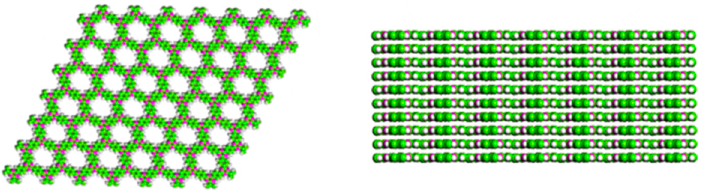
Figure 1. Top-down and side view of covalent triazine frameworks (CTF)-1, with a crystalline ordered structure [6].